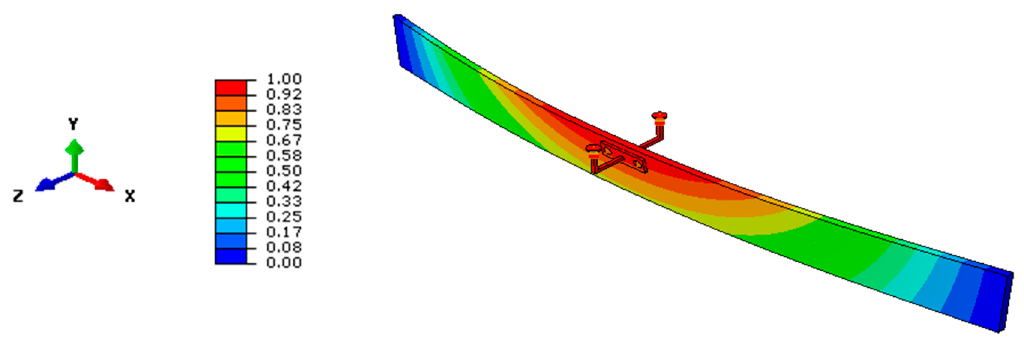
Figure 11. Example of fundamental critical shape (ABAQUS) for a glass beam in LTB ( n b = 1, x b = L / 2) with LR details according to Figure 10.